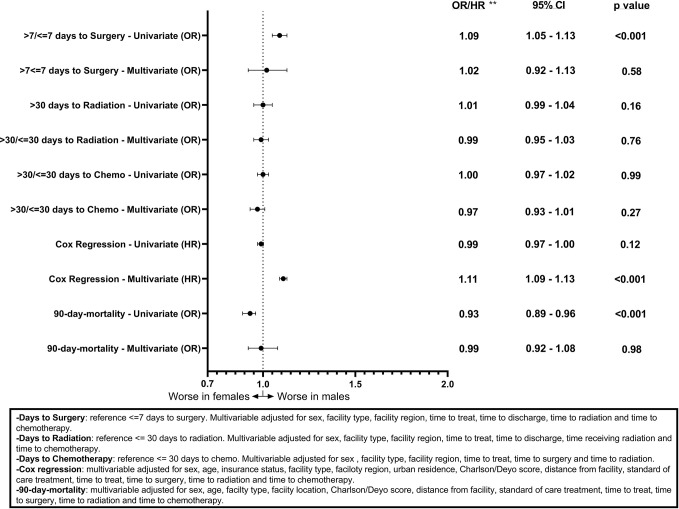
Forest plot of sex differences in clinical outcomes for GBM, National Cancer Database (NCDB), 2004–2016. **Odds ratios from logistic regression for days to surgery, days to radiation, days to chemotherapy, and 90-day mortality and Hazard ratios from Cox regression for overall survival.